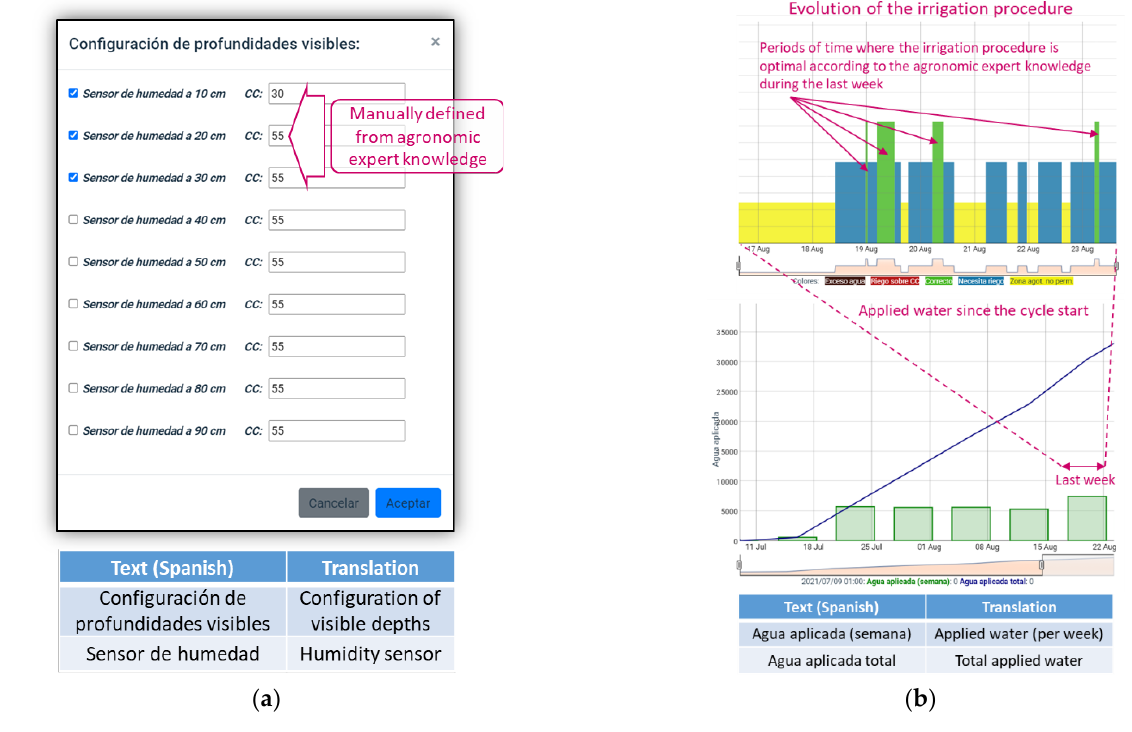
Figure 10. Other tools provided by the Irriman Platform. ( a ) Dialog for configuring the FC for each depth and for selecting which ones are active. ( b ) Charts for analyzing if the irrigation procedure is optimal.